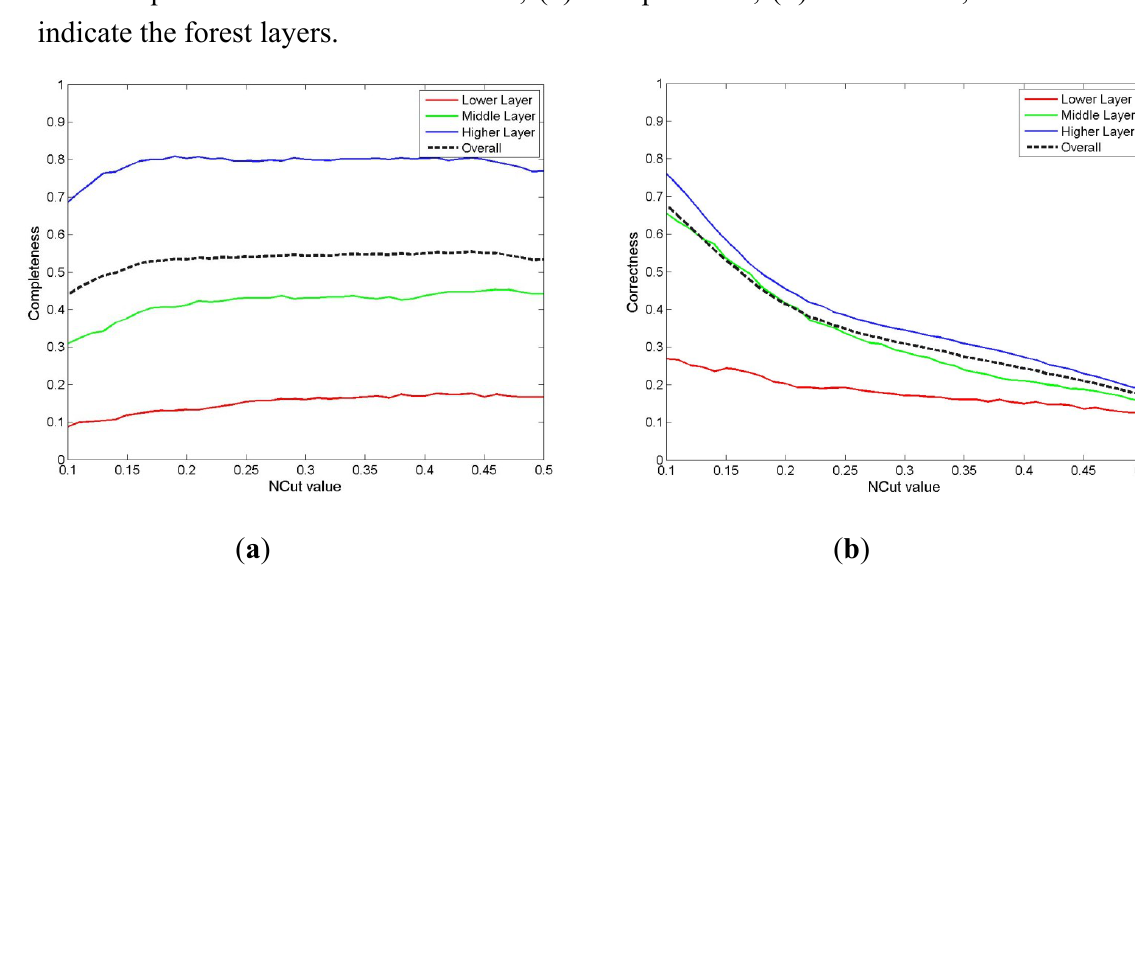
for the dataset of Test Thres